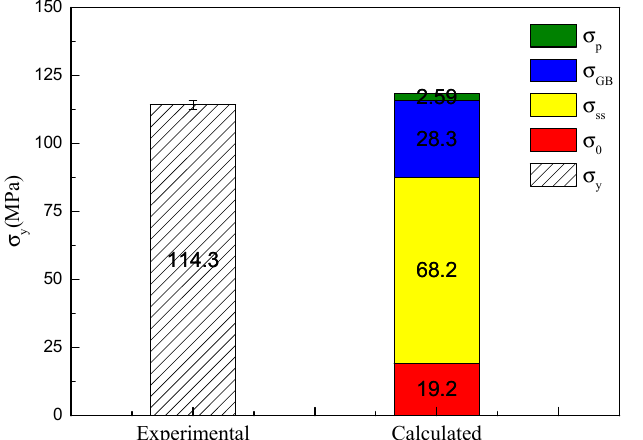
Figure 10. Comparison of calculated and measured yield strength of as-cast Al-Mg alloy with Sc.